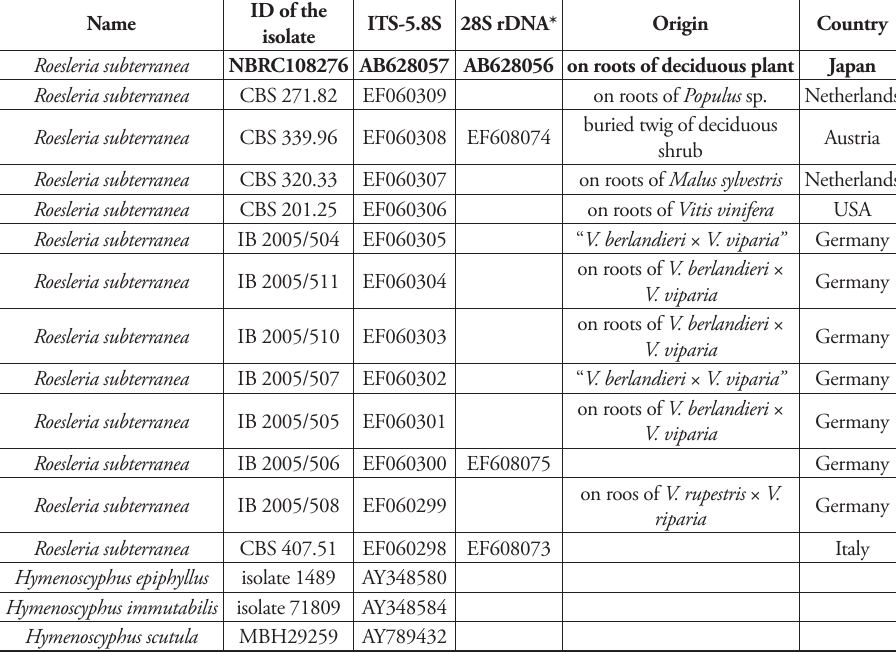
Table 1. Sequences used in the present study. New sequences generated for this analysis are in bold.